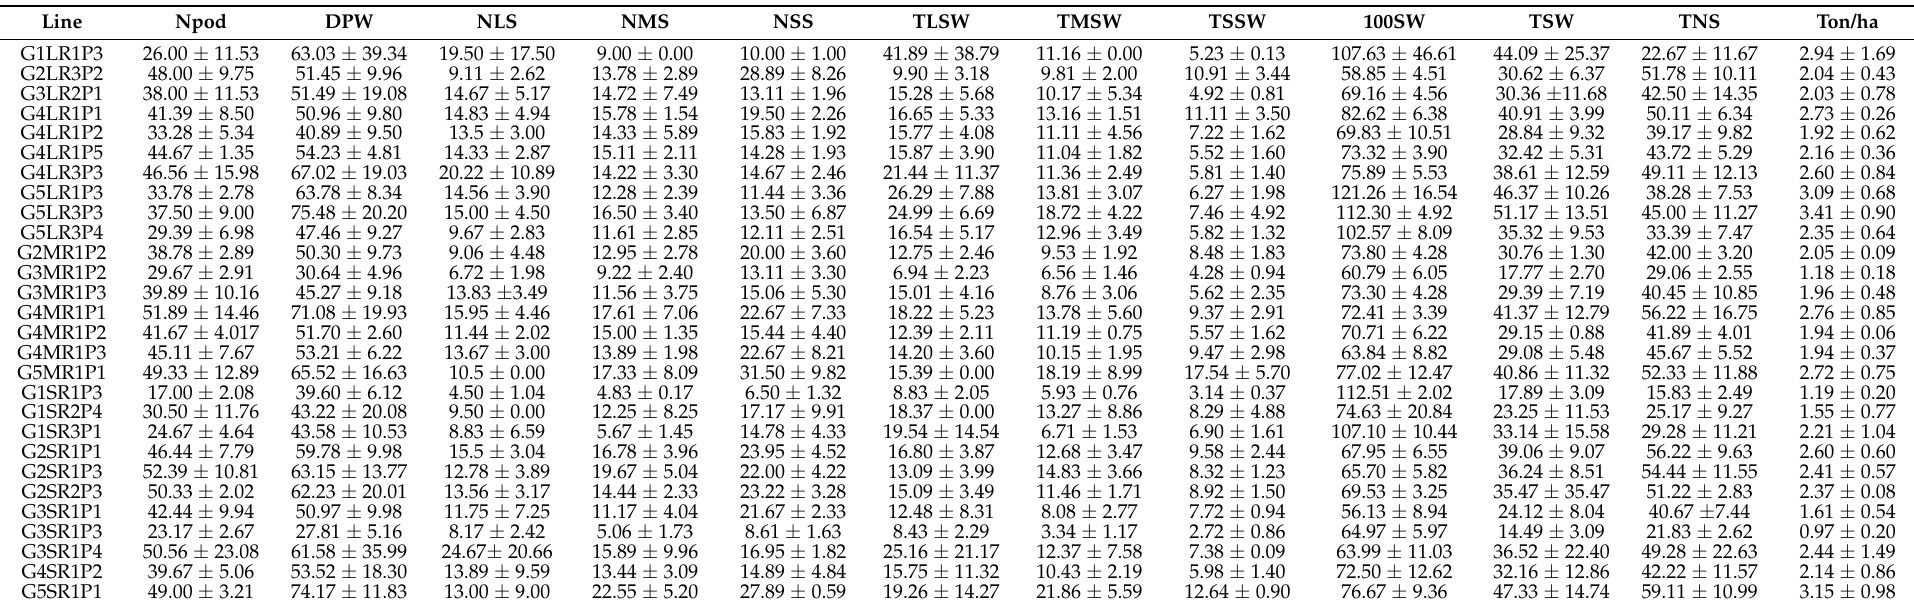
Table 5. Means comparison for the yield